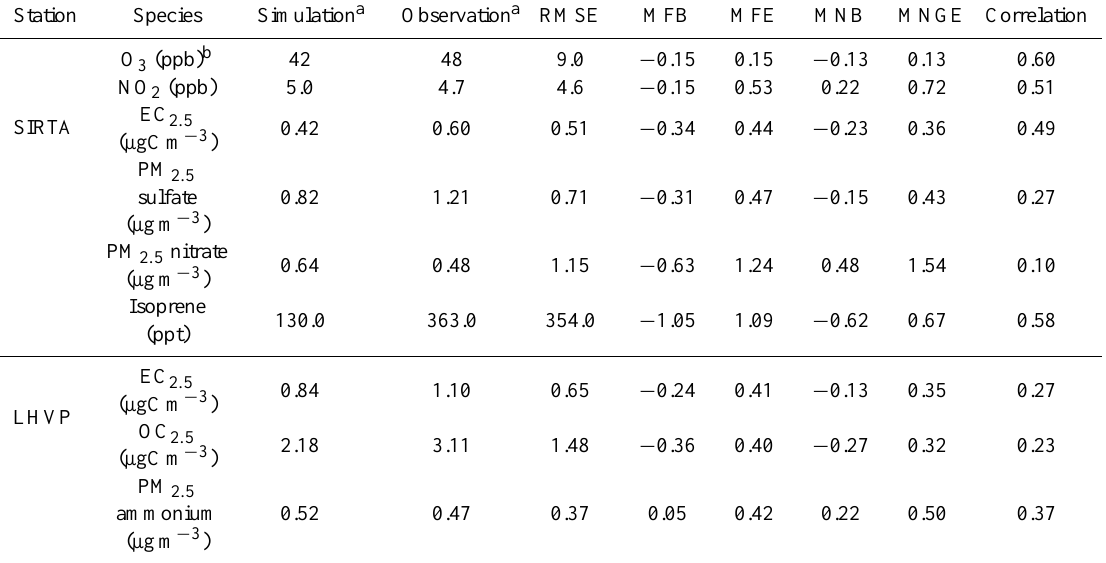
Table 3. Comparison of the modeled concentrations and observations during the Megapoli campaign. Performance statistics were calculated with hourly mean concentrations for all species. The units of the simulated and observed concentrations and RMSE are indicated. Other performance metrics are unitless. Station Species Simulation a Observation a RMSE MFB MFE MNB MNGE Correlation